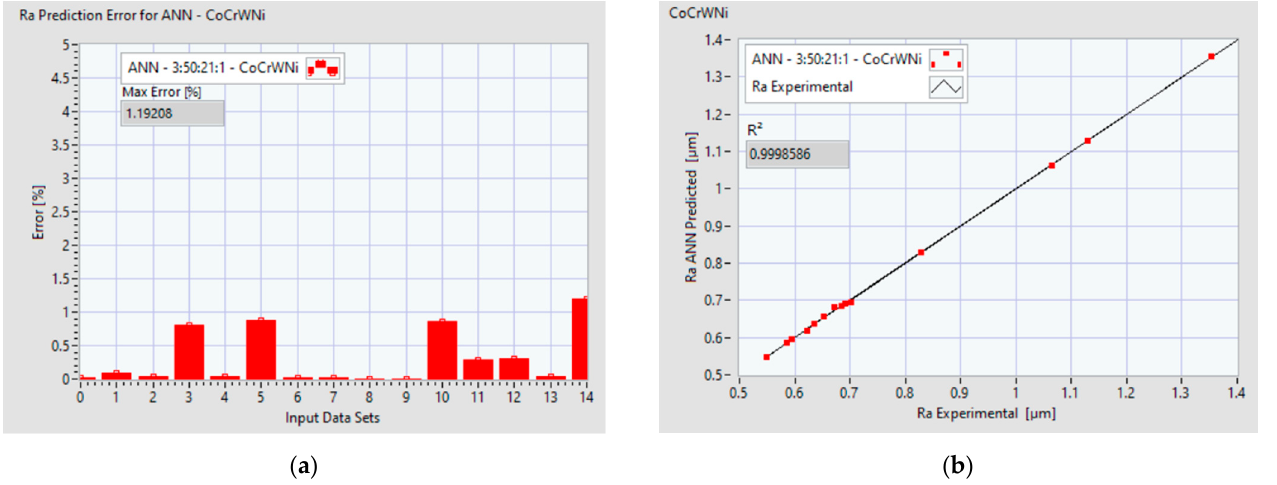
Figure 15. Ra prediction performance of ANN 3:50:21:1 for Co–20Cr–15W–10Ni: ( a ) error distribution per data set; ( b ) coefficient of determination R 2 and correlation between the predicted values and entire data.